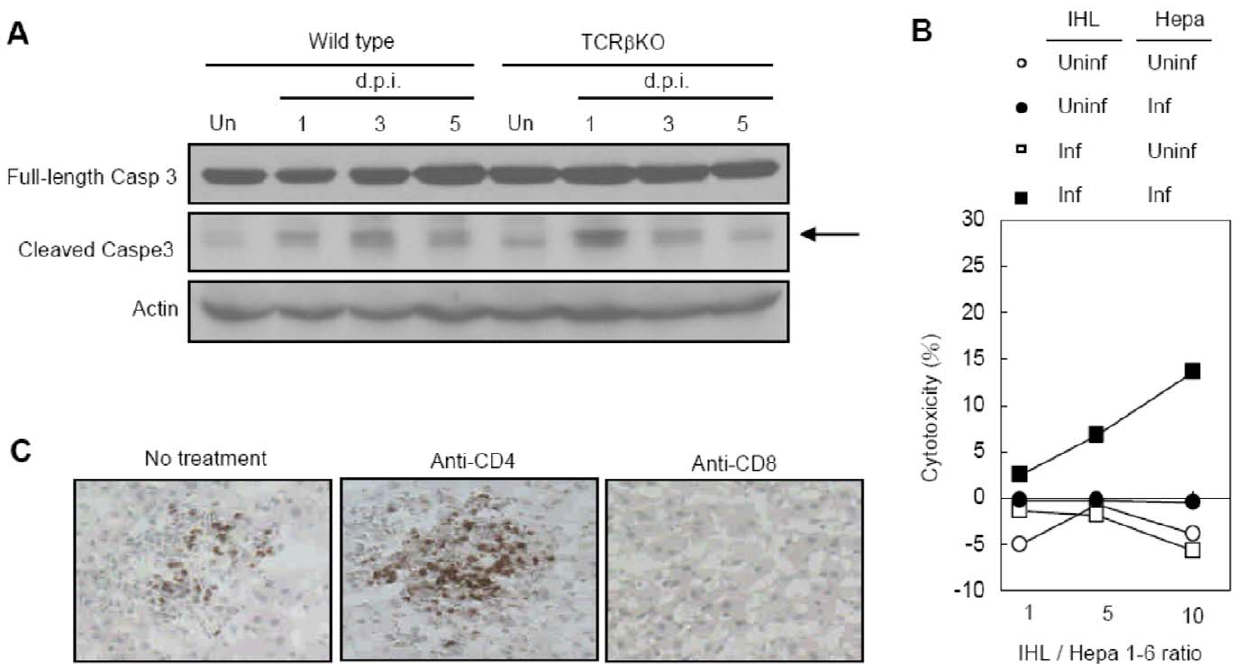
Figure 4. Intrahepatic T cells are cytotoxic against DENV-infected hepatocytes. (A) Liver lysates were collected from uninfected and infected wild type and TCR b KO mice. Arrow points to cleaved capase 3. Data presented are representative of three independent experiments ( n= 3 per time point in each experiment). (B) Uninfected (Uninf) or infected (Inf) Hepa 1–6 were co-cultured with IHLs isolated from uninfected (Uninf) or infected (Inf) mice at different ratio. Data presented are representative of three independent experiments ( n= 3 per time point in each experiment). (C) Liver cryosections from infected mice at day 5 with or without anti-CD4 and anti-CD8 antibody were stained with TUNEL reagents. Data presented are representative of three independent experiments ( n= 3 per time point in each